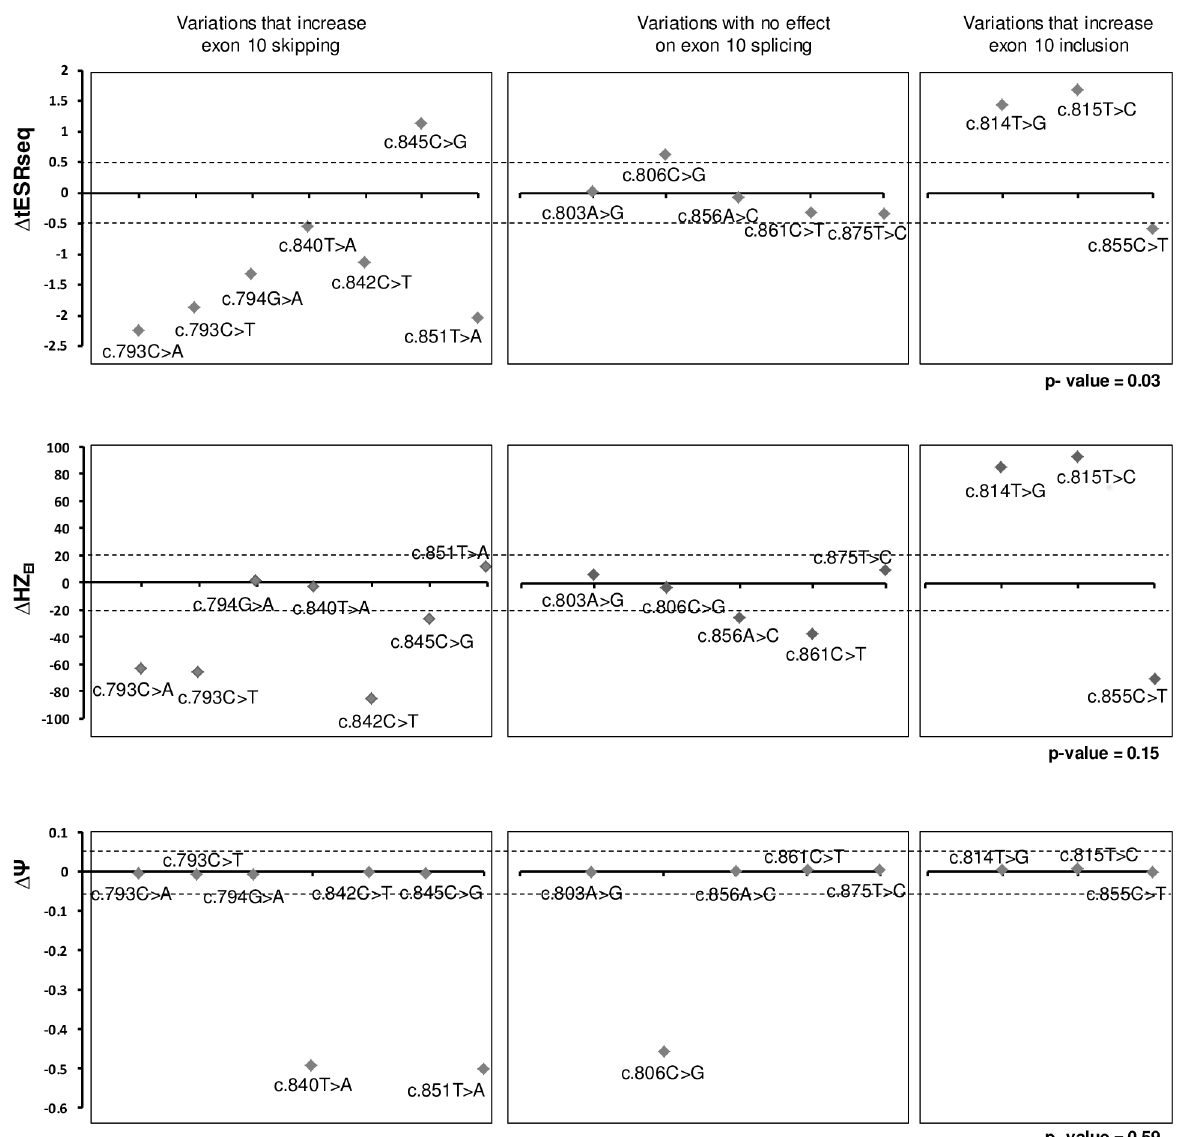
Fig 3. Comparison of pSPL3m-M1e10 minigene data with results obtained from new ESR-dedicated bioinformatics tools. Top, middle and bottom panels refer to results obtained with Δ tESRseq-, Δ HZ EI- and ΔΨ -based bioinformatics approaches, respectively, as described under Materials and Methods. MLH1 exon 10 variants located within the sequences that define the reference splice sites were eliminated from this analysis. Retained variants were separated into 3 groups depending on their impact on splicing as determined on the pSPL3m-M1e10 minigene assay and indicated above the graphs. Dashed lines indicate the thresholds used in this study. P-values were calculated by using the one-way ANOVA test, as described under Materials and Methods.